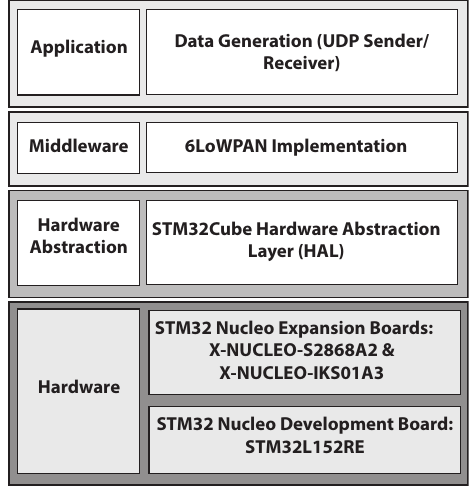
Figure 7. X-CUBE-SUBG2